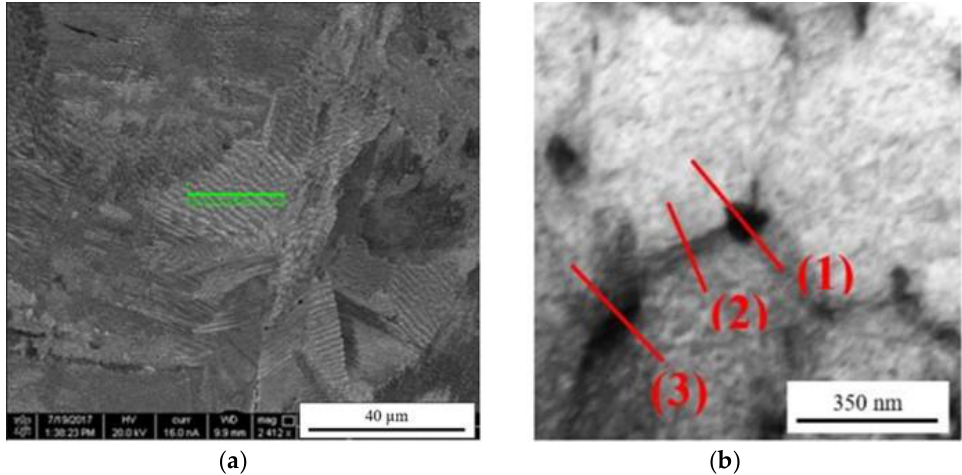
Figure 5. SEM BSE image showing rectangular region of interest in green that was extracted using FIB ( a ) and the corresponding TEM BFI image showing location of EDS scans in red in the STEM mode ( b ).